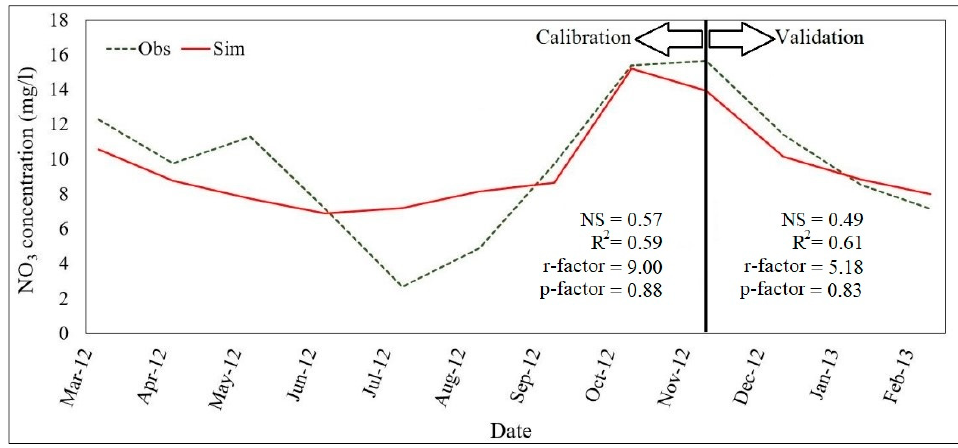
Figure 7. Calibration and validation of monthly phosphate concentration in Dezful station (2012–2013).